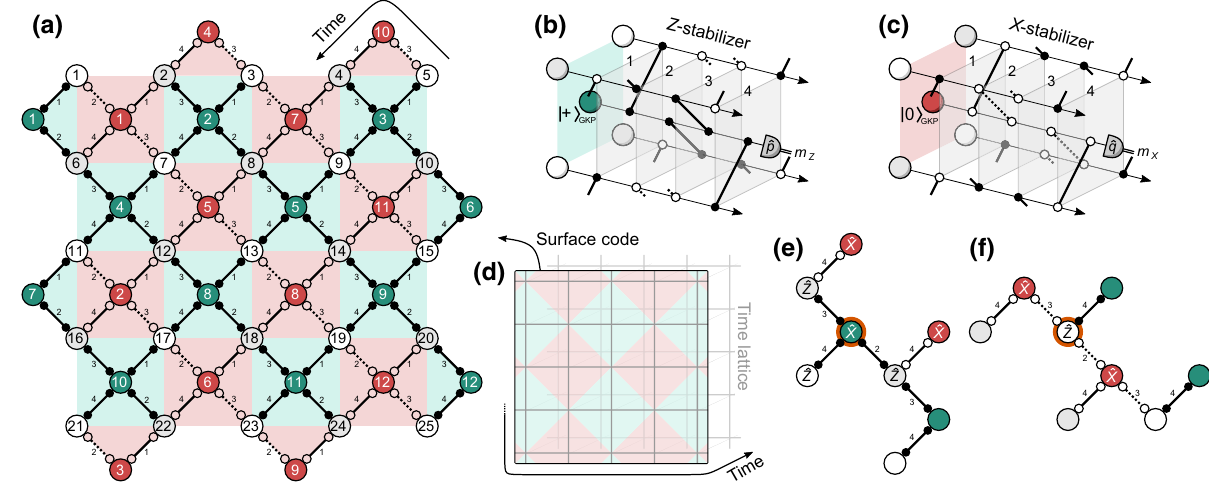
FIG. 4. (a) Illustration of a logical qubit for the d = 5 rotated surface code. The white and gray circles represent odd and even data qubits, respectively. The green and red circles represent Z - and X -measure qubits, respectively. The two-mode gate operations are listed in Eq. (9), and the labels 1 to 4 indicate the time steps in which those gates are implemented. (b),(c) Illustration of one round of syndrome measurements, including the initialization of the encoded GKP ancilla qubits, four time steps for the coupling between the data and ancilla qubits by four measurement-induced two-mode gates, and a measurement using the TDMD. For the surface-GKP code, GKP quadrature corrections are performed on data qubits at the beginning of a surface-code syndrome measurement cycle. For the surface-4-GKP code, GKP quadrature corrections are performed on all data and ancilla qubits after each gate. (d) Orientation of the surface code in the 3D time lattice of the computation scheme shown in Fig. 2. Here, the surface code is encoded in two dimensions of the time lattice with vertices corresponding to encoded GKP qubits, while gates are encoded in each step along the third dimension of the time lattice. (e,f) Example of qubit errors induced by GKP quadrature correction in the surface-4-GKP code. In (e), an ˆ X Pauli error occurs in a measure- Z ancilla after the first two-mode gate of a surface-code syndrome measurement round. The error then propagates to neighboring data and measure- X ancillas via the subsequent two-mode gates used to measure the surface-code stabilizers. In (f), a ˆ Z Pauli error occurs in a data qubit after the first two-mode gate and propagates to two measure- X ancillas. See Appendix C for an examination of all possible Pauli errors, how they propagate, and the corresponding edges in the matching graphs for